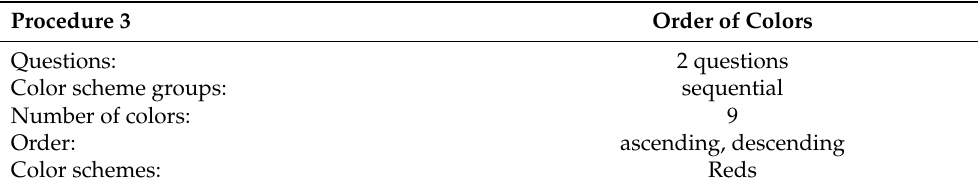
Table 12. Header of the third procedure.